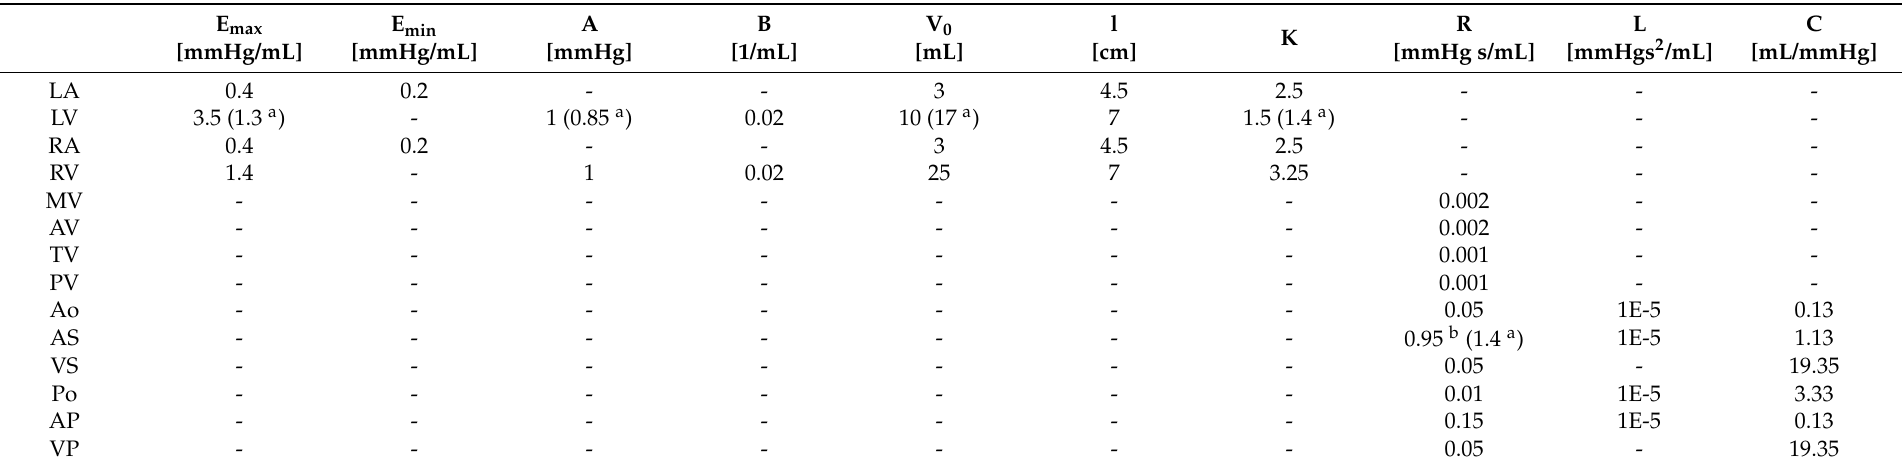
Table 1. Parameter values used in the cardiovascular system models. a Numbers in the brackets were used to simulate DCM and continuous-flow VAD support; b R as value used in the cardiovascular system models simulating the healthy condition and continuous-flow VAD support. (LA, left atrium; LV, left ventricle; RA, right atrium; RV, right ventricle; MV, mitral valve; AV, aortic valve; TV, tricuspid valve; PV, pulmonary valve; Ao, aorta; AS, systemic arterioles; VS, systemic veins; Po, pulmonary artery; AP, pulmonary arterioles; VP, pulmonary veins; E max , maximal elastance; E min , minimal elastance; A, a parameter used in the ventricle models; B, a parameter used in the ventricle models; V 0 , zero-pressure volume; l, long axis length; K, scaling coefficient used in the heart chamber models; R, resistance; L, inertance; C,